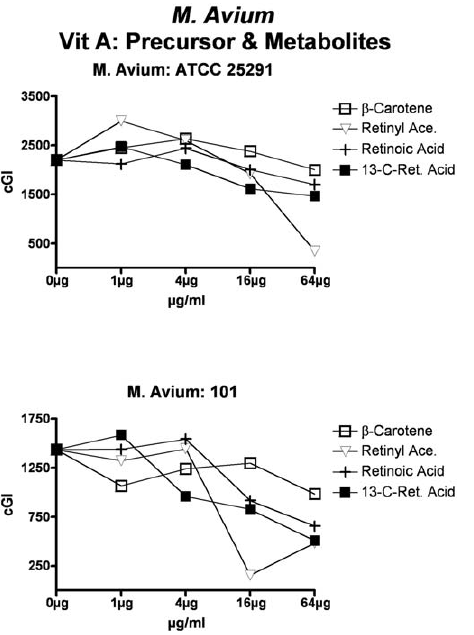
Figure 8. The effects of vitamin A precursors and metabolites on M. avium . ß-carotene, the precursor to vitamin A, exhibits no inhibition at the doses studied. Retinyl acetate and 13-cis Retinoic acid have some inhibition.